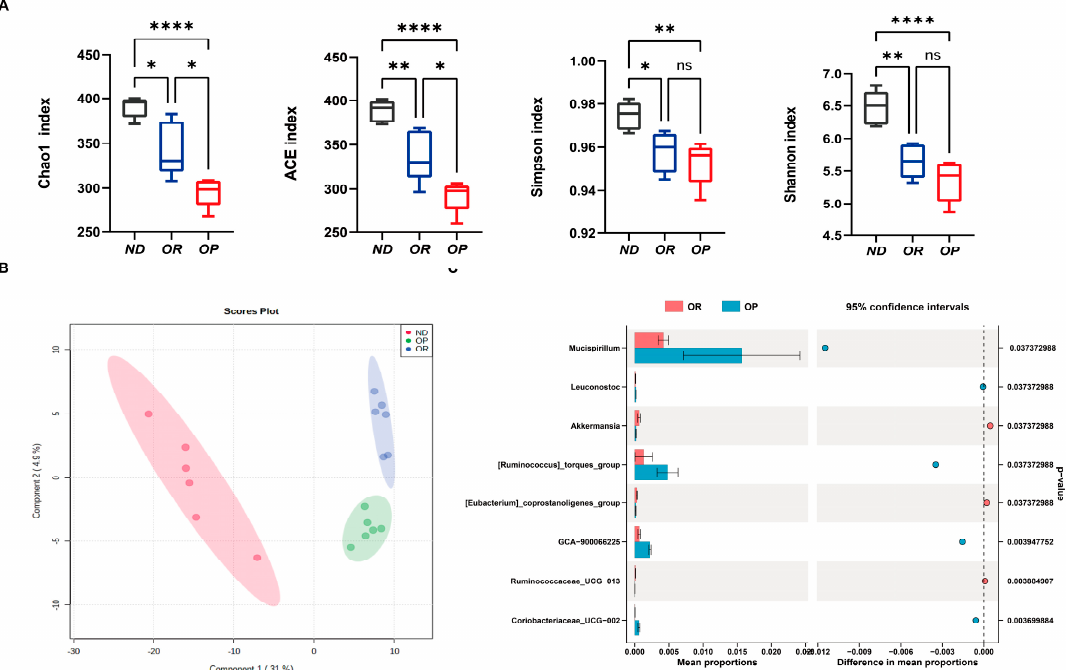
Figure 2. Significantly different microbiota structures were observed between OR and OP groups. ( A ) Comparison of alpha diversity indices in the OR versus OP groups. ( B ) Partial least-square discriminant analysis (PLS-DA) scores plot of OTU level showing the groupings of ND (red) group, OP (green), and HF-OR (blue). ( C ) Extended error bar plot between the OP and OR groups at the genus level. * p < 0.05, ** p < 0.01 and **** p < 0.0001 were considered signi fi cant. ns , not significant .